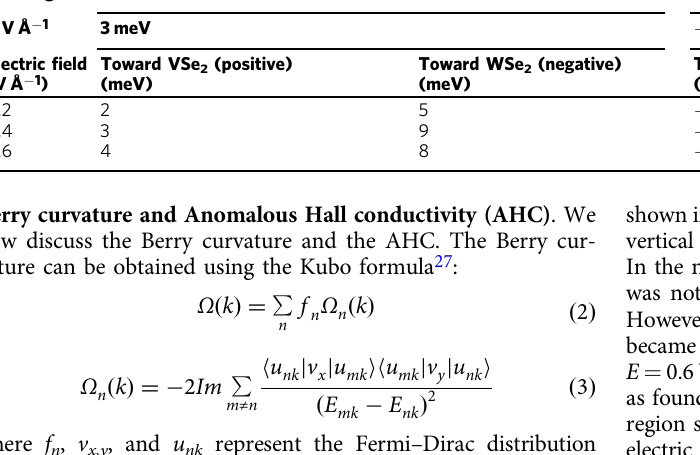
Table 1 Electric fi eld-dependent valley polarization of C-I and C-II stackings.